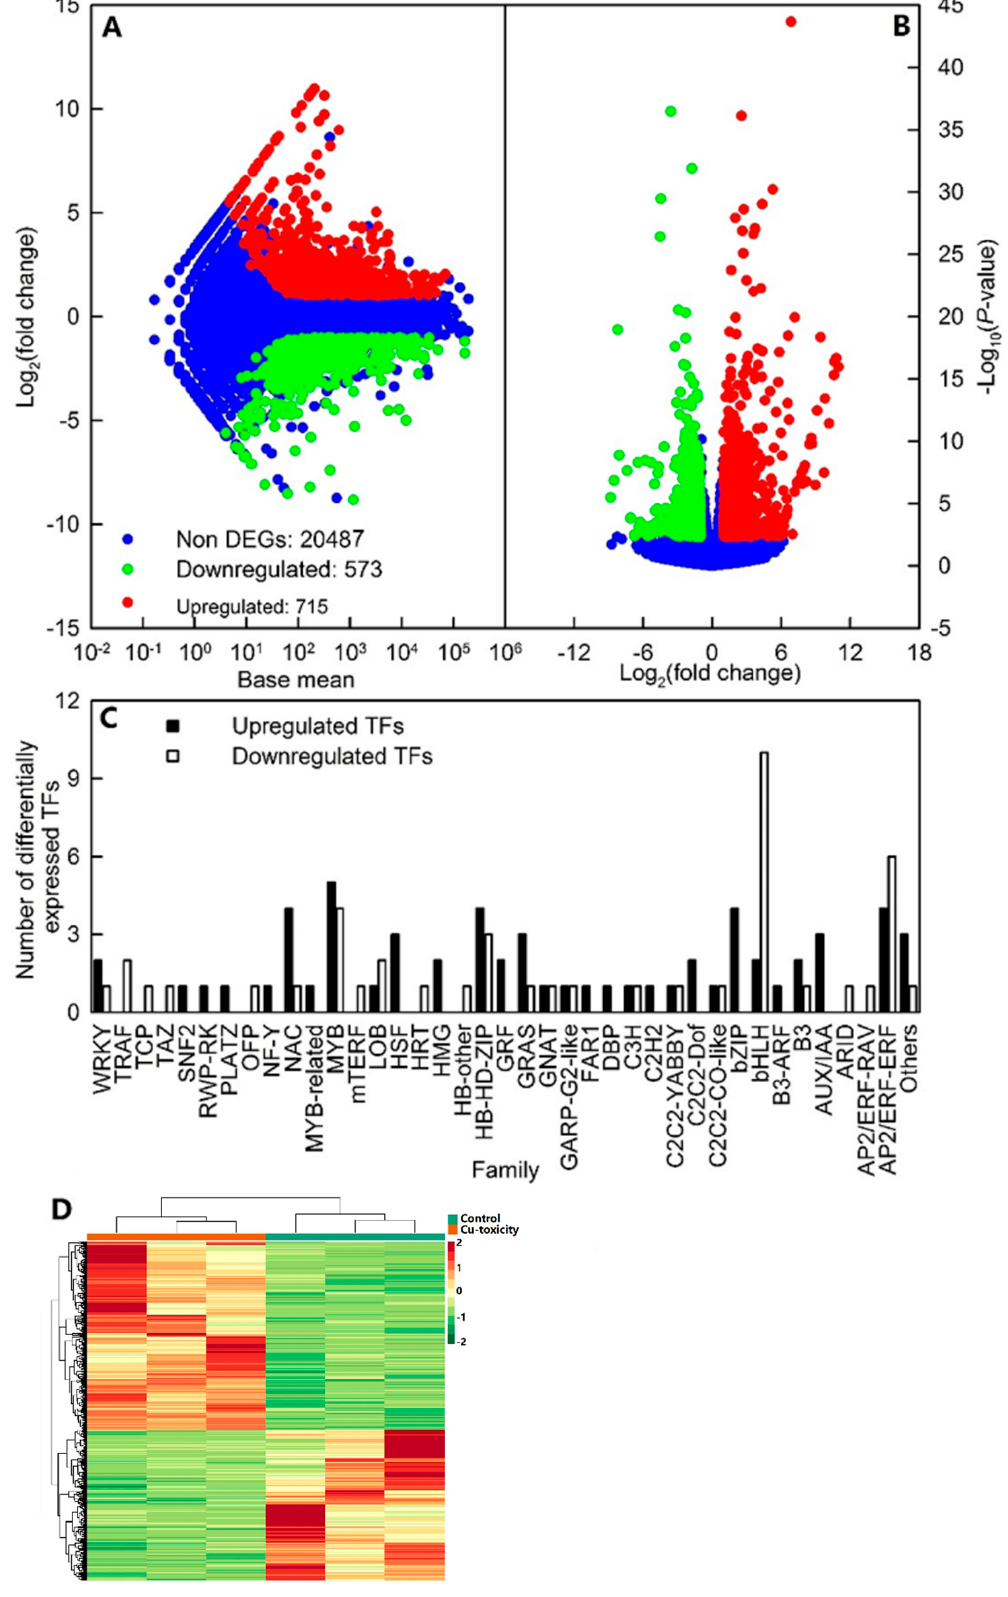
Figure 3. MA map ( A ) and volcano plot ( B ) of differentially expressed genes (DEGs), upregulated and downregulated transcription factors ( TFs , C ), and cluster analysis of DEGs ( D ) in leaves of C. grandis seedlings exposed to Cu-toxicity (LCGSEC).